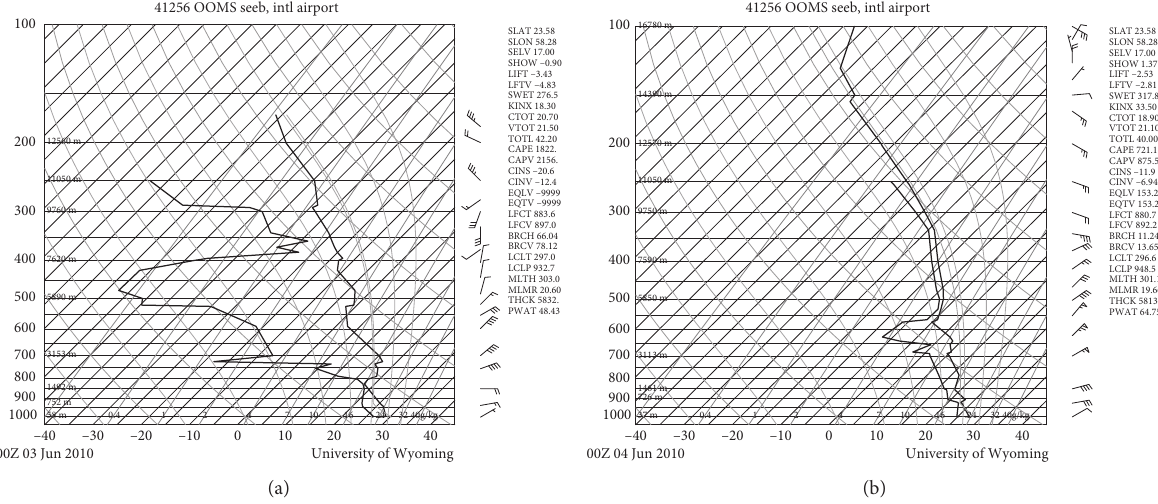
Figure 10: The upper air sounding on the (a) 3rd of June 2010 and (b) 4th of June 2010 (source: University of Wyoming,